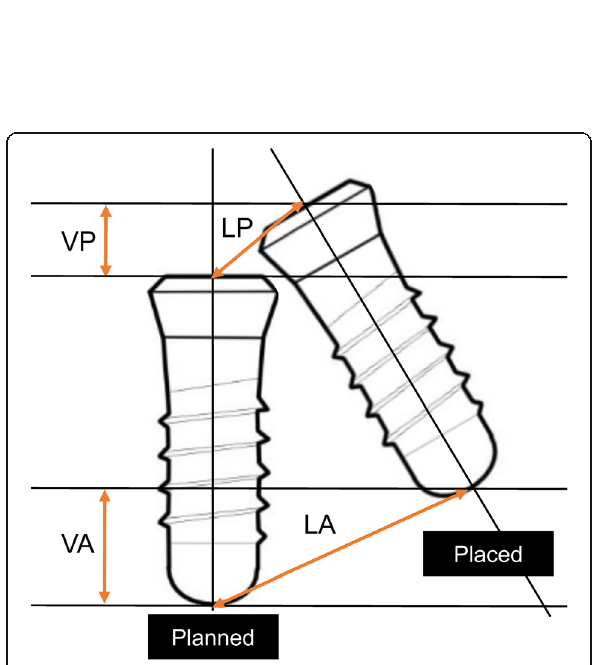
Fig. 3 Parameters for implant deviation measurement. VP, vertical deviation at implant platform (mm); VA, vertical deviation at implant apex (mm); LP, linear deviation at implant platform; LA, linear deviation at implant apex (mm)